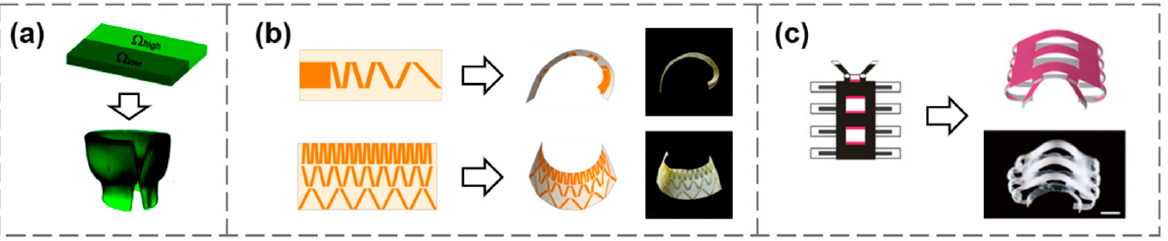
Figure 1. Diverse shape-morphing caused by discretely patterned in-plane inhomogeneities in an initially flat configuration. ( a ) A bi-gel strip with differential swelling ratios rolls into a nearly cylindrical shape after swelling. Reproduced from Ref. [57]; ( b ) Stretching-induced surfaces with different curvatures. Reproduced from Ref. [72]; ( c ) The crystallization pattern and deformed geometry of a worm-like shape. Reproduced from Ref. [58].